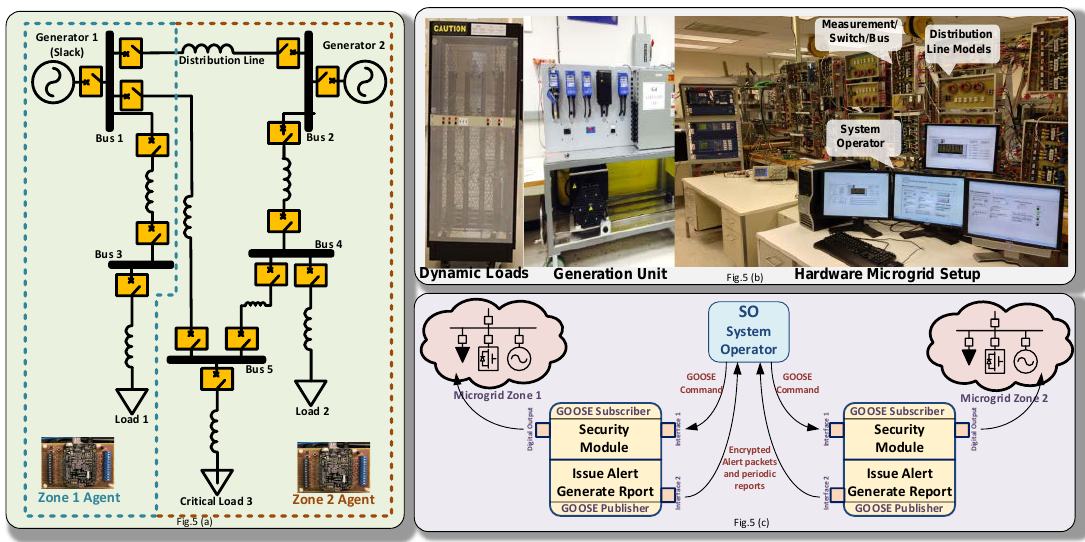
Figure 6. ( a ) One-line diagram of the 5-bus hardware microgrid; ( b ) Actual laboratory setup; ( c ) Network topology of agents.